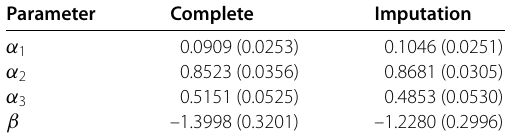
Table 4 The estimates and standard errors of α and β by two different methods from the diabetes data